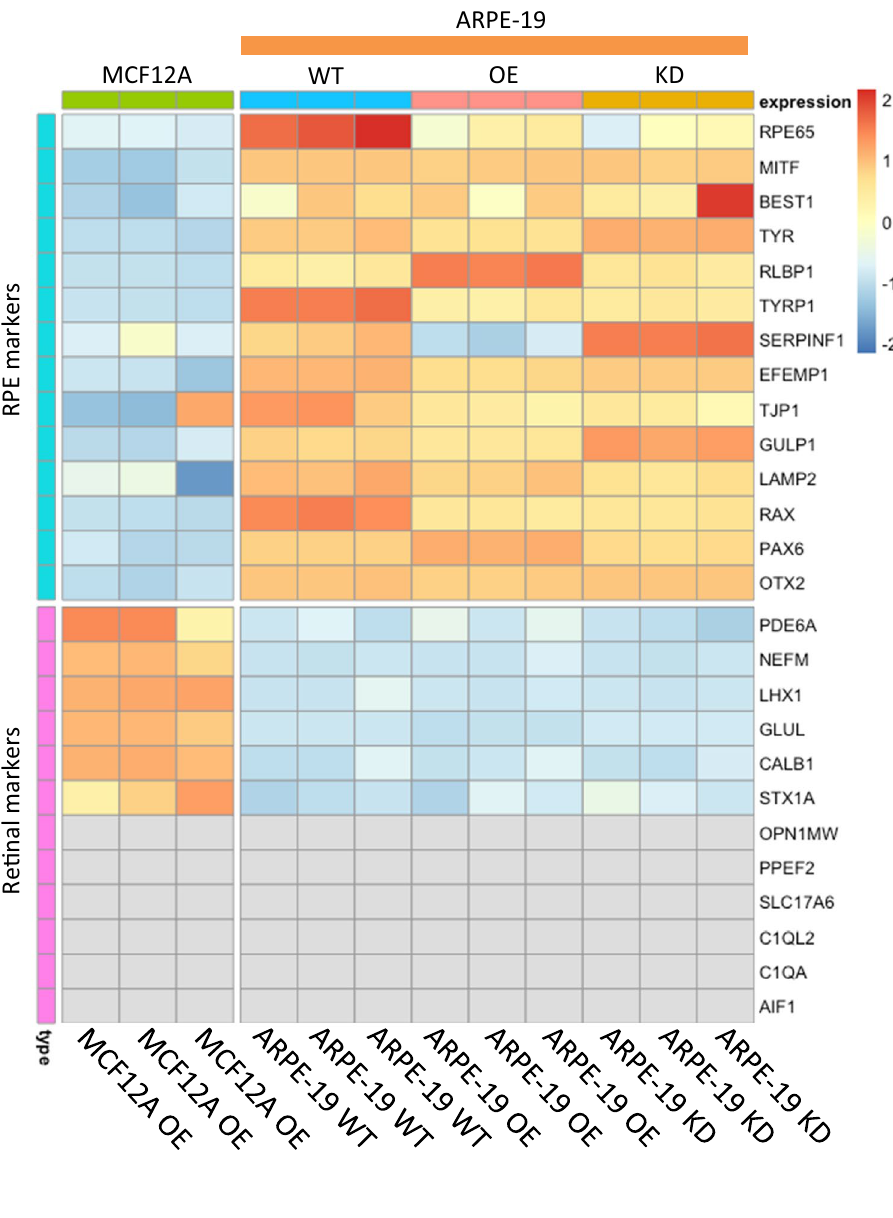
Figure 2. RNA sequencing of ARPE-19 cells for RPE and retinal markers. Wild type (WT), EMP2 overexpressing (OE), and EMP2 knock down (KD) ARPE-19 cells were queried for differential expression of classical RPE markers and retinal markers. A control cell line, MCF12A (immortalized breast cancer cell line) was analyzed in parallel, and results are presented as a heatmap generated in R studio using pheatmap, version 1.0.12 (https:// CRAN.R- proje ct. org/ packa ge= pheat map.) High expression of RPE markers and low expression of retinal markers was observed in ARPE-19 cells, regardless of EMP2 expression. Both MCF12A and ARPE-19 cells showed low expression of most retinal markers (gray indicating zero transcripts identified). All samples were performed in